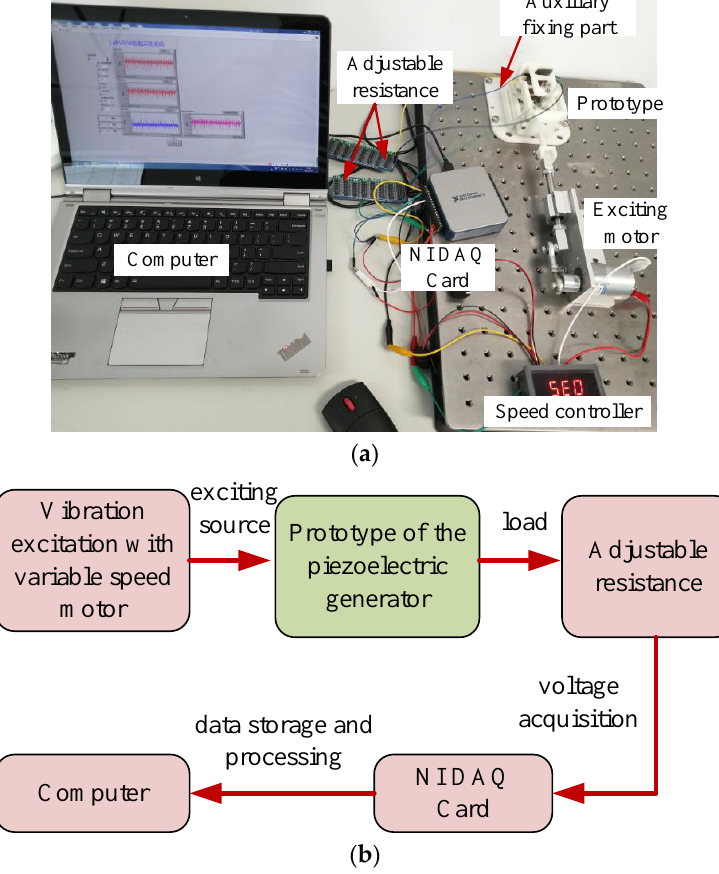
Figure 5. Experimental test system of the micro-power piezoelectric generator. ( a ) Test platform; ( b ) experimental schematic diagram. Table 3. Performance parameters of the flexure strip.